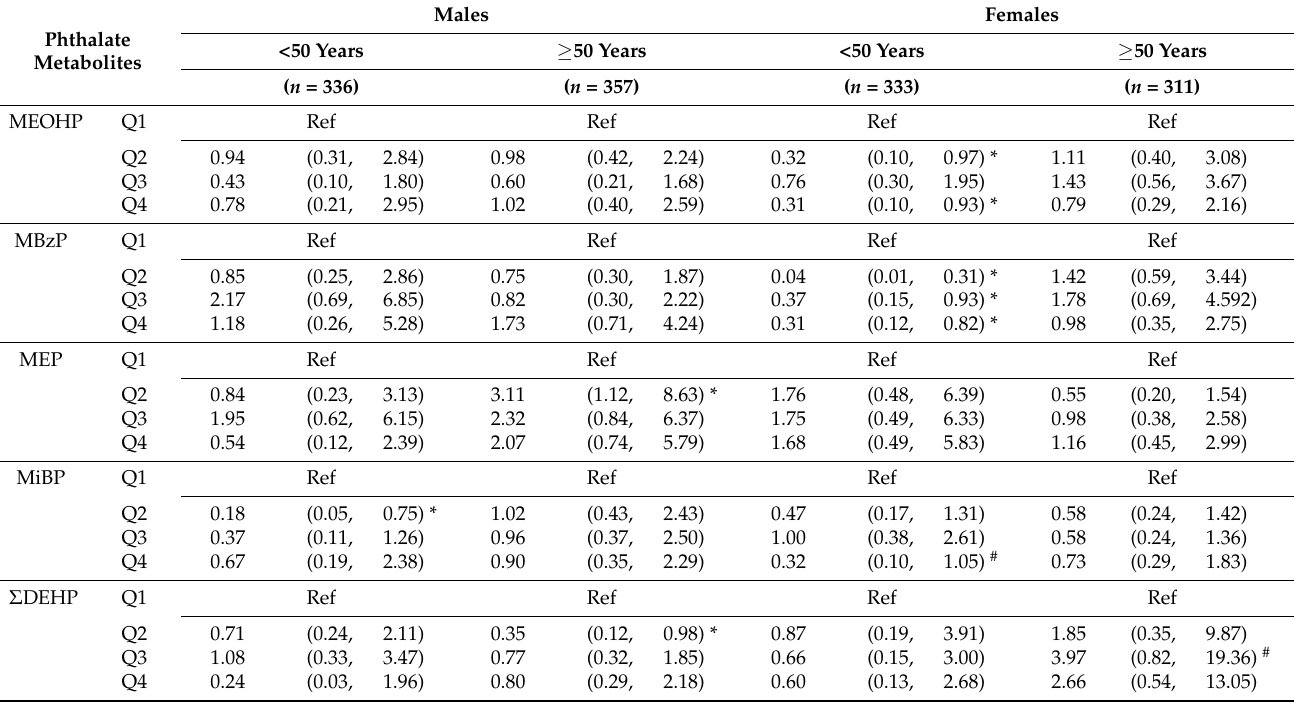
Table 5. Prevalence odds ratios and 95% confidence intervals for MetS stratified by age and